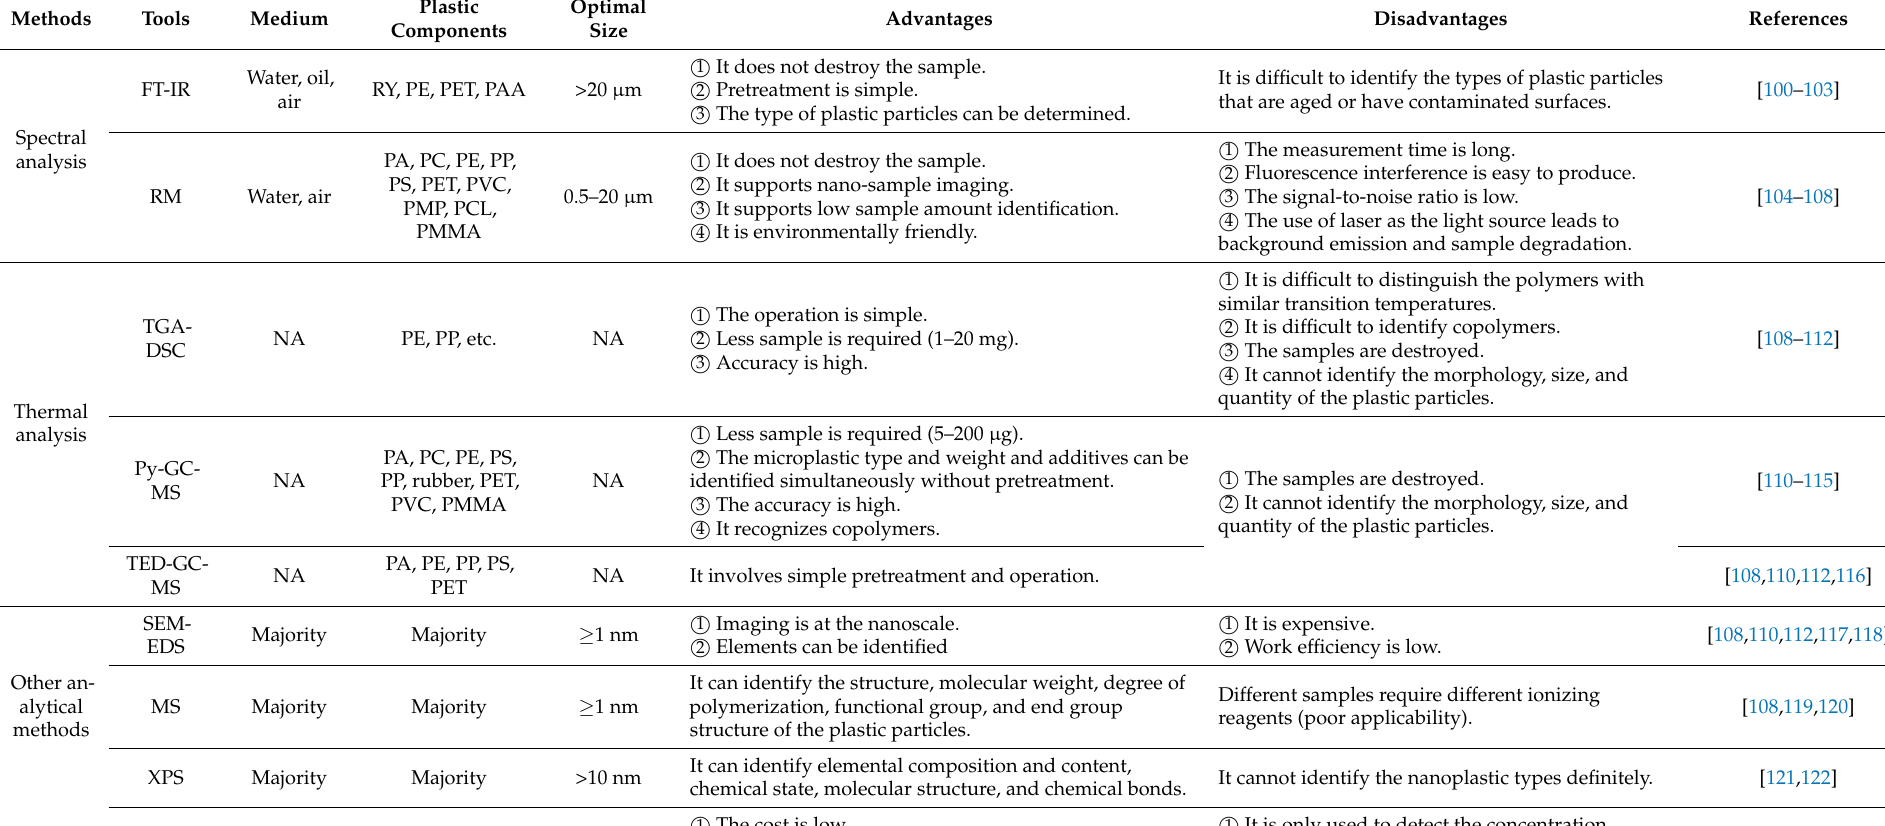
Table 3. Outstanding methods for the analysis of microplastics and nanoplastics in the atmospheric